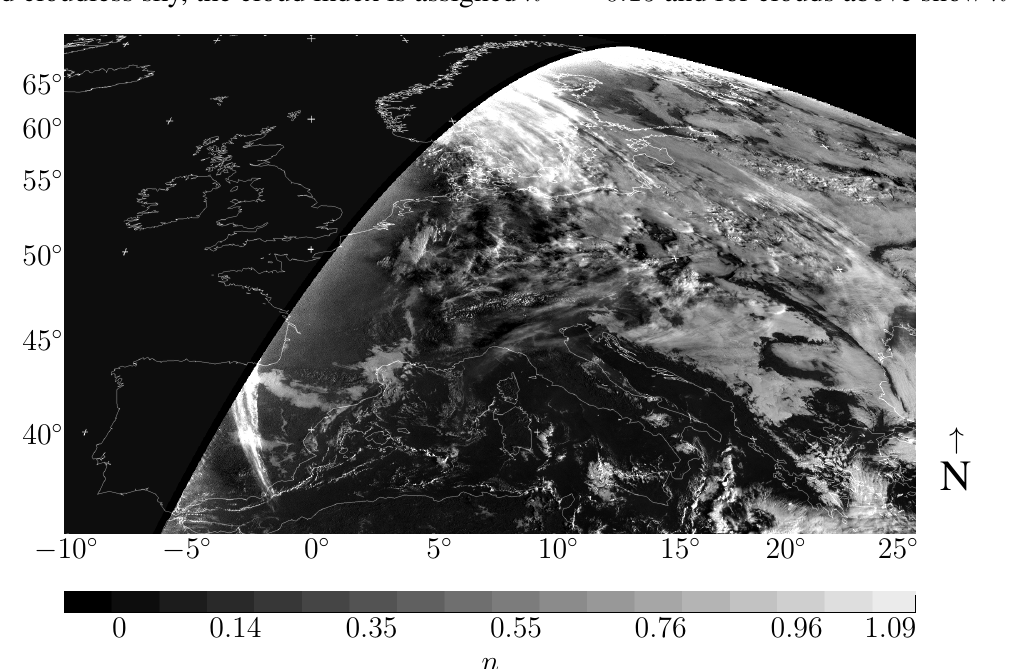
Figure 3. Cloud index image for Europe, 1 November 2014, 0645